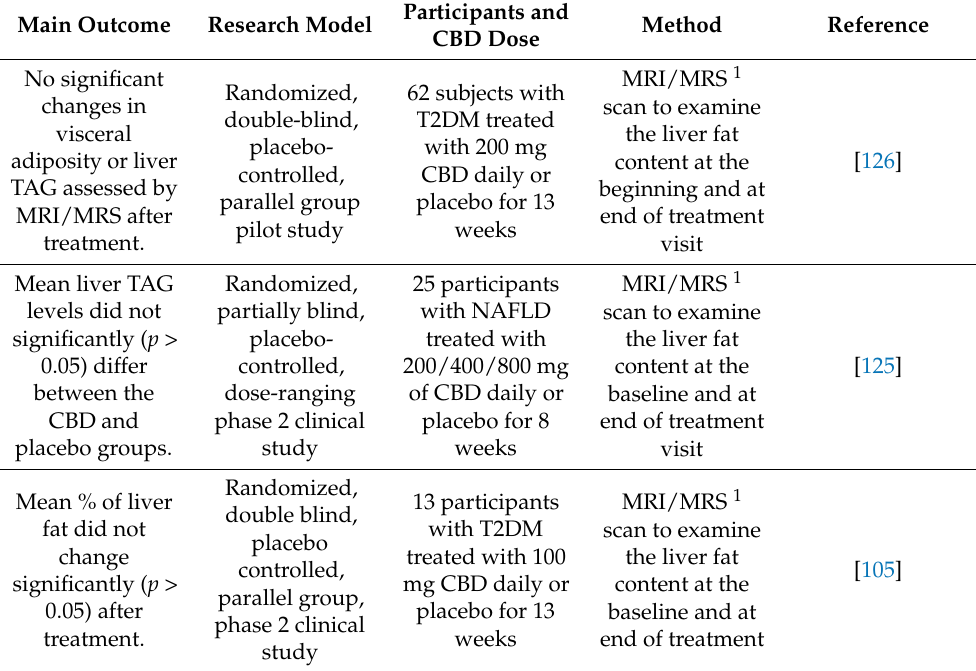
Table 4. Clinical studies analyzing the effects of CBD on liver fat